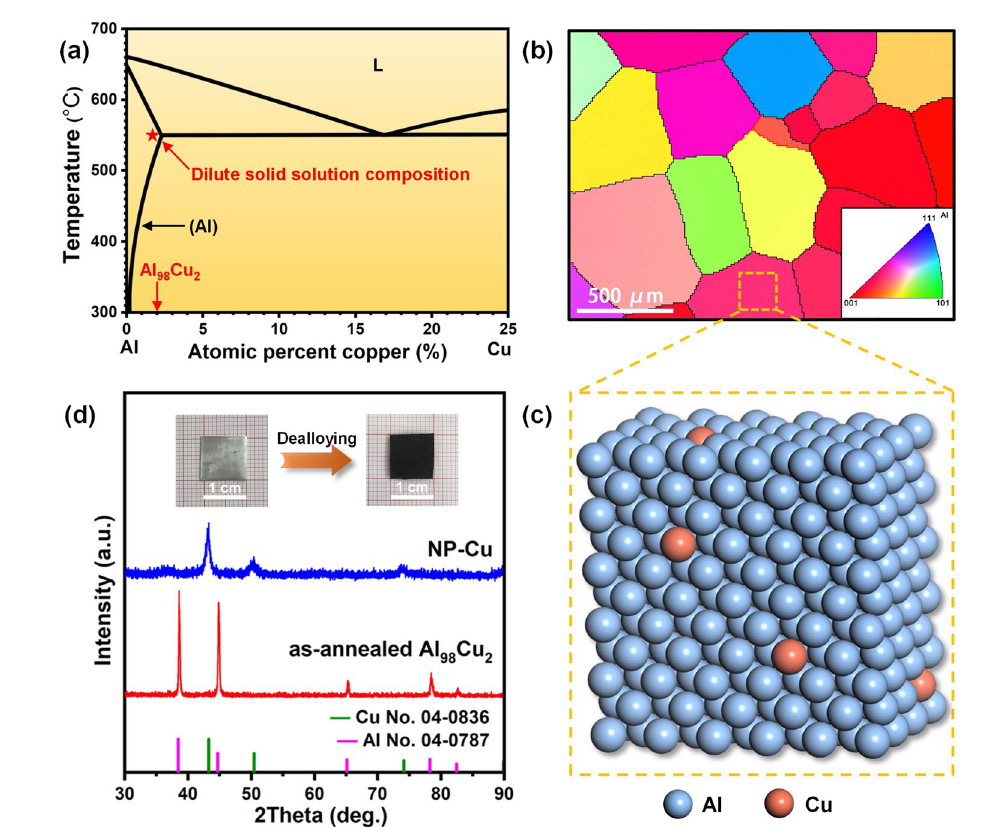
Fig. 1 a Phase diagram of Al-Cu indicating the design of dilute solid solution alloy. b EBSD image (Inset: corresponding crystallographic ori- entation) and c schematic diagram of the crystal structure of the Al 98 Cu 2 precursor. d XRD patterns (Inset: photographs of the samples before and after dealloying) of the as-annealed Al 98 Cu 2 precursor and the NP-Cu